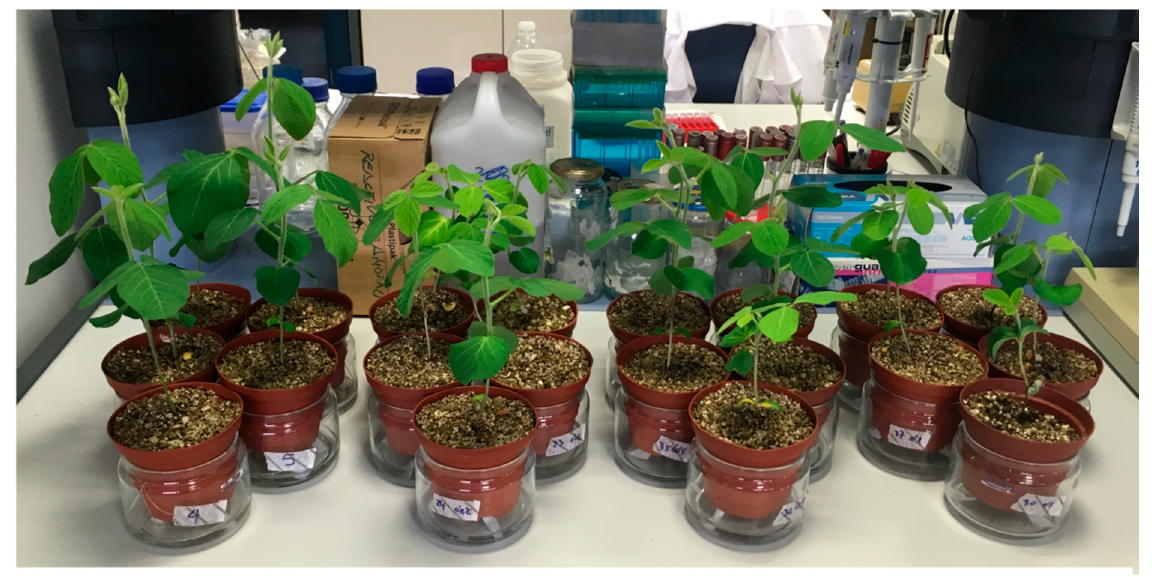
Figure 1. Leonard jars used for growth of soybean plants inoculated with B. diazoefficiens 110 spc 4 and treated or not treated with paraquat. From left to right: 0, 20, 50 and 100 µM, respectively.